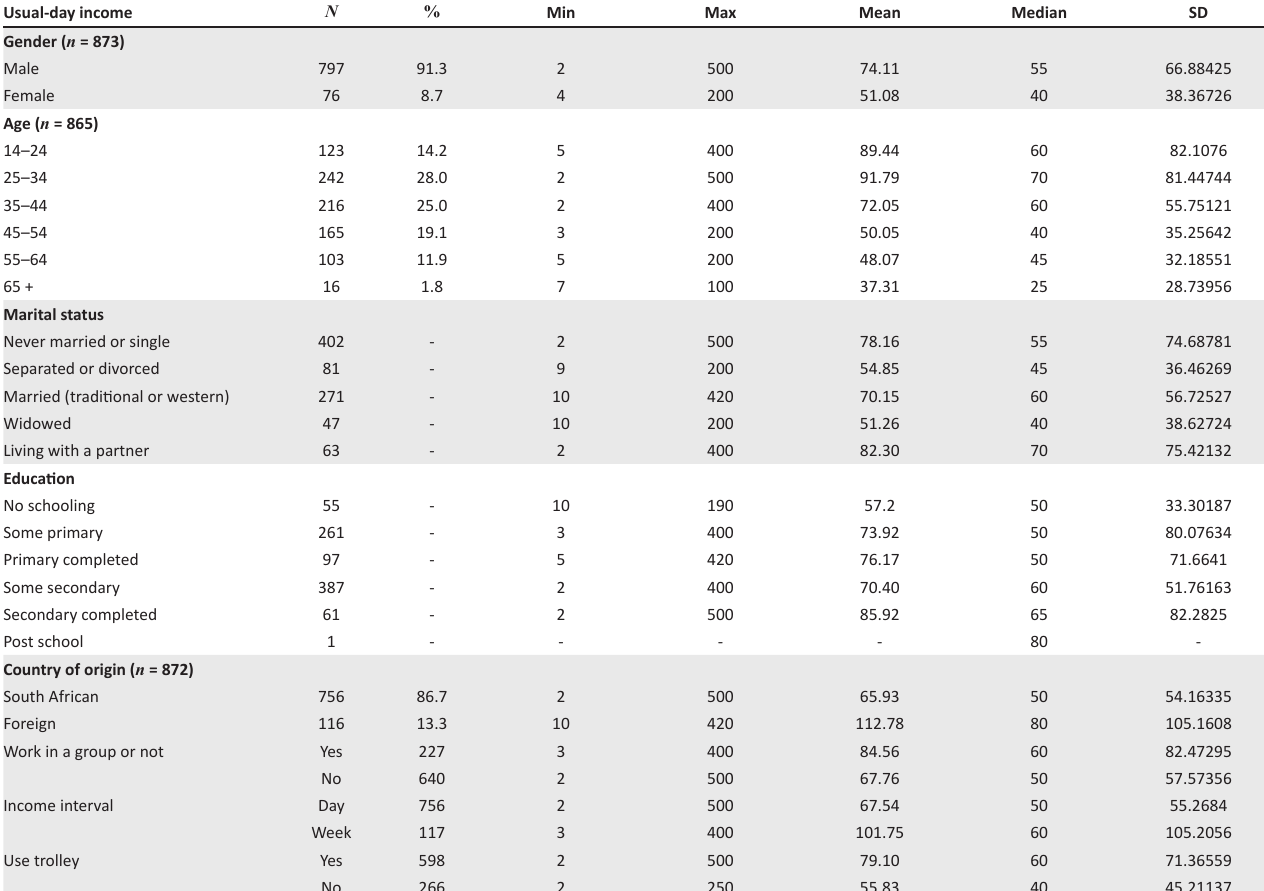
TABLE 2: Income differences according to the demographic characteristics and working conditions and/or practices of the street waste pickers. Usual-day